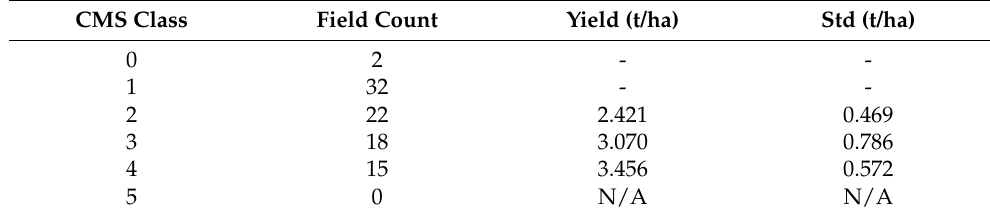
Table 5. Yield estimation for sunflower in the 2022 growing